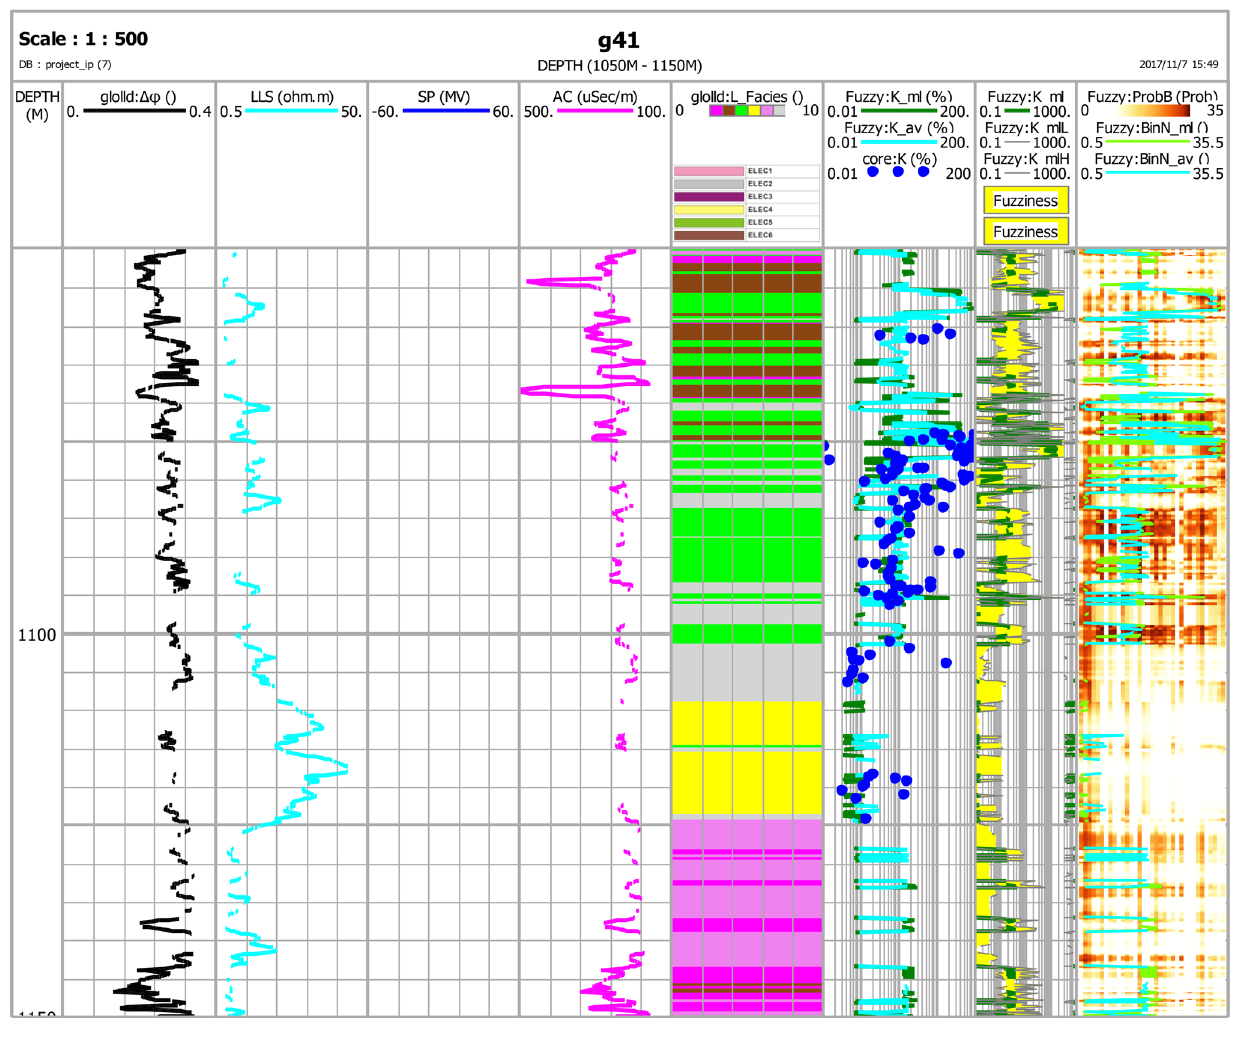
Fig. 21 The well plot of Well G41 between 1000 and 1150